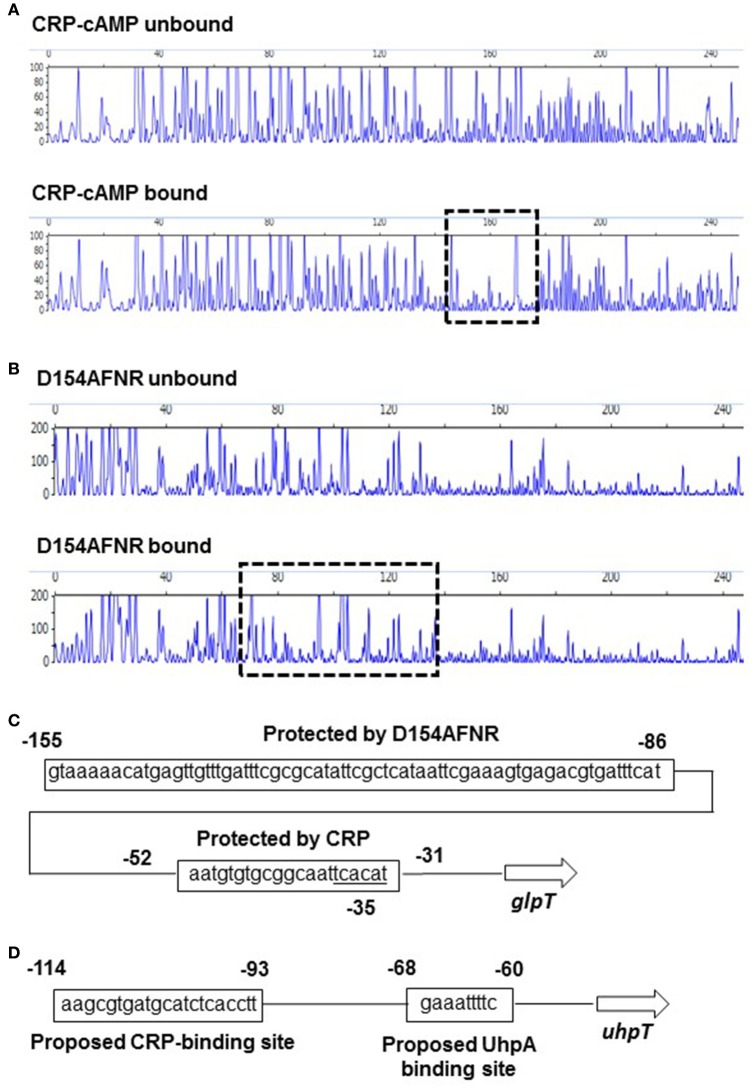
Sequences of the upstream glpT and uhpT region and identification of CRP-cAMP and D154AFNR binding sites. DNase I footprinting of the glpT promoter region. A 300-bp, 6-FAM-labeled DNA fragment was incubated in the presence or absence of CRP (20 pmol) containing cAMP (A) or D154AFNR (20 pmol) (B) and subjected to DNase I digestion. The fluorescence intensities of the DNA fragments (y axis) are plotted relative to their size in bases (x axis). One region (outlined by the dashed line) was protected from DNase I digestion in the presence of 20 pmol protein. (C) Sequence of the upstream glpT region. The region protected from DNase I digestion is indicated by the box. Numbers indicate relative positions to the transcript start site labeled +1. Predicted −35 box is indicated. (D) Sequence of the upstream uhpT region. The CRP and UhpA binding site reported in previous studies (Merkel et al., 1995; Olekhnovich et al., 1999) are indicated by the box. Numbers indicate relative positions to the transcript start site labeled +1.